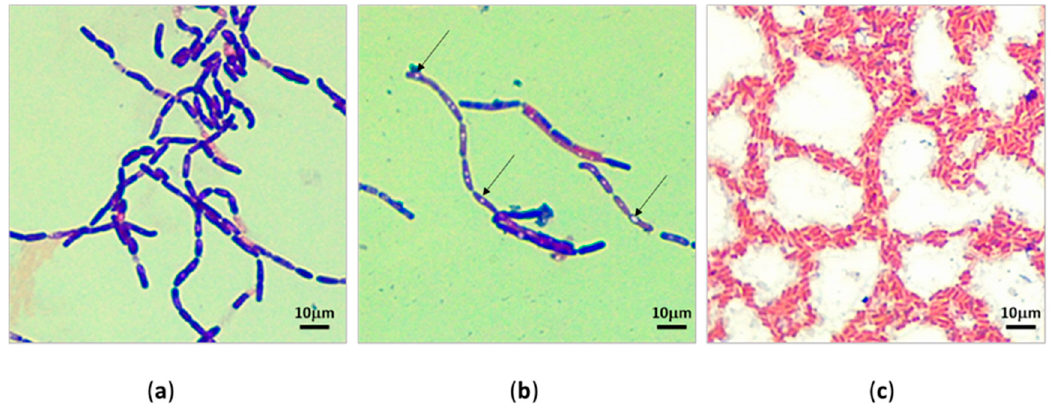
Figure 3. Light microscopy of subcultured bacterial isolates under oil immersion lens (10 × 100). ( a ) Gram-positive bacilli isolated in April cutaway site; ( b ) Gram-positive bacilli with sub-terminal endospores, the arrows point to the sub-terminal endospores; ( c ) Gram-negative short rods isolated in April cutaway site.